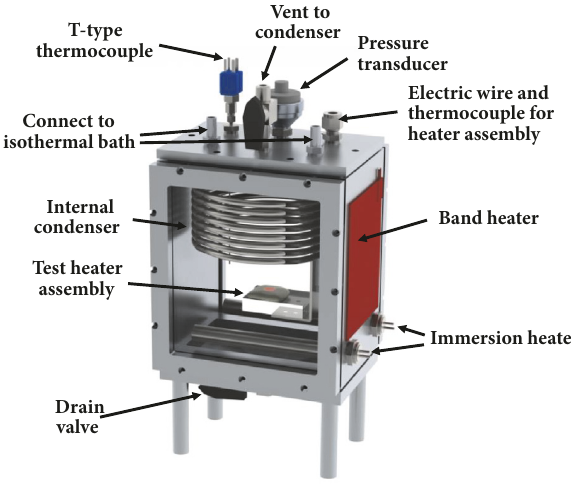
Figure 1: Schematic of the pool boiling chamber.